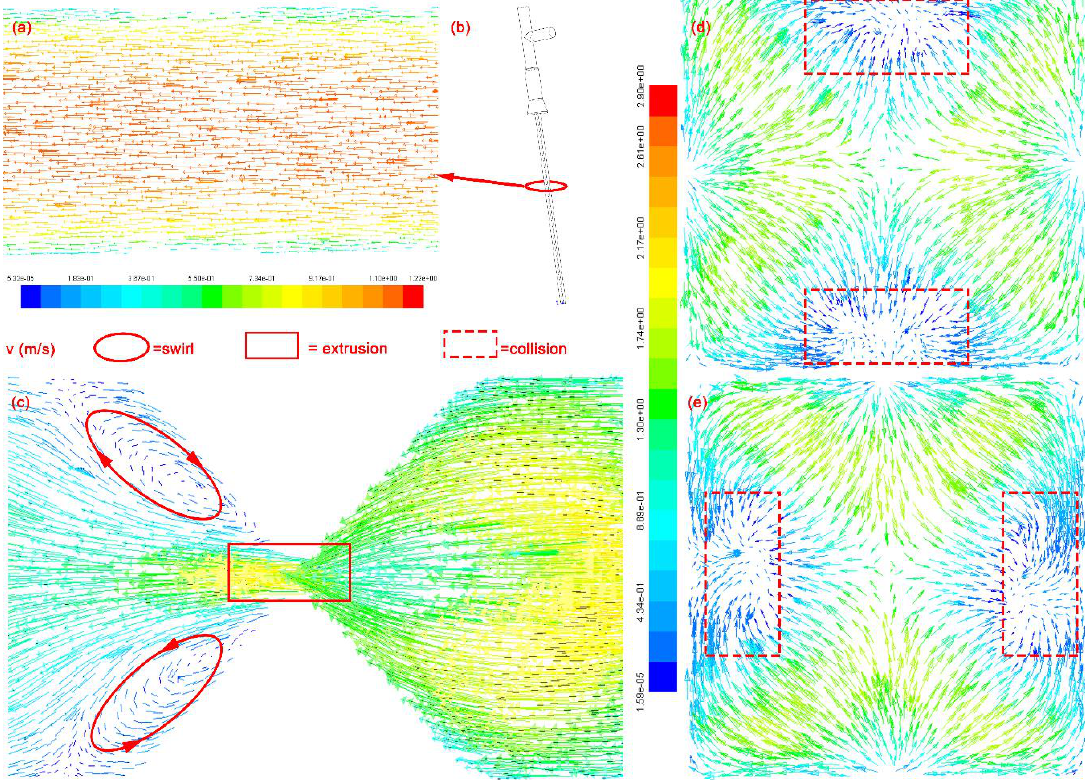
Figure 10. Velocity vector diagram of different conditions: ( a ) velocity vector diagram of the free channel (axial); ( b ) watershed model of the unobstructed micro reacting pipe; ( c ) velocity vector diagram with obstruction (axial), ( d , e ) velocity vector diagram of two successive obstacles (vertical axis).